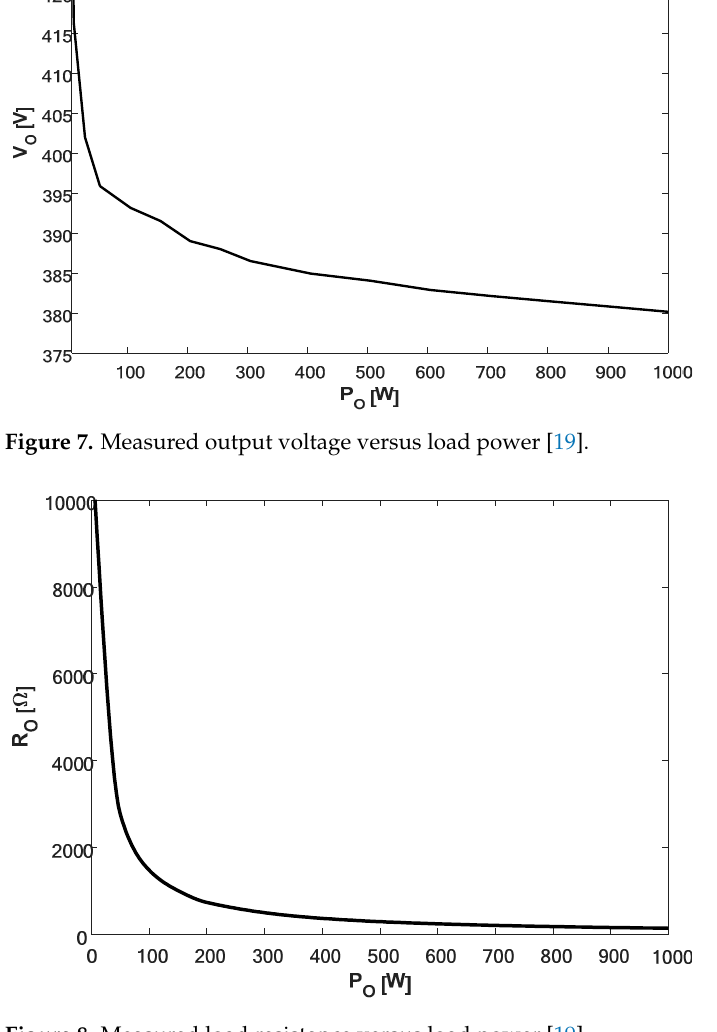
Figure 8. Measured load resistance versus load power [19].